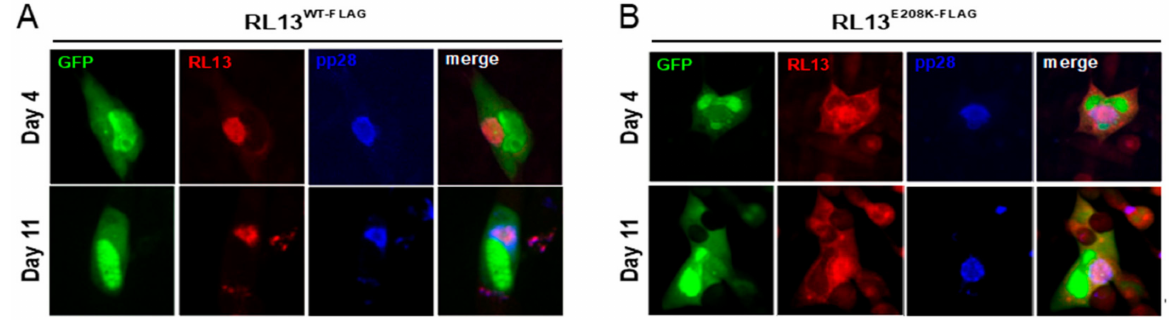
Figure 7. RL13-FLAG localizes to VAC and is mis-localized by the E208K substitution. MRC- 5 monolayers were infected with p0 stocks of TL12-RL13 WT-FLAG ( A ) or TL12-RL13 E208K-FLAG ( B ). After four or 11 days, the cultures were imaged for GFP (green), stained for RL13 with an α -FLAG antibody (red), or stained for pp28 with an α -pp28 antibody (blue). Original magnification: 200 ×